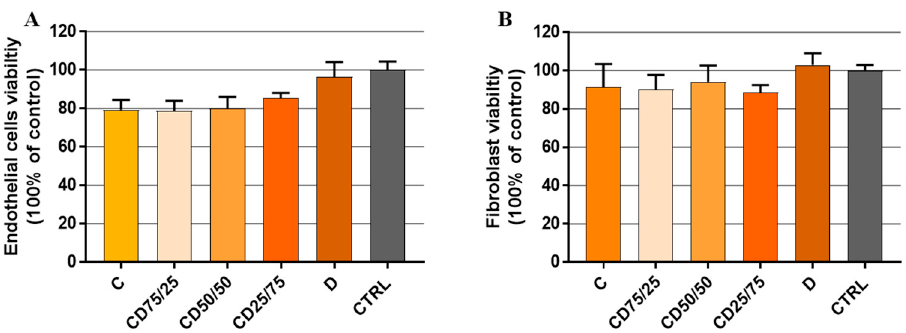
Figure 7. The viability of endothelial cells ( A ) and fibroblasts ( B ), after cultivation on different CD hydrogels, was determined by XTT assay. Cells were seeded for 72 h on the hydrogels or in a normal TPC culture plate (CTRL). Results are expressed as a mean ± standard deviation (SD) ( n = 3).